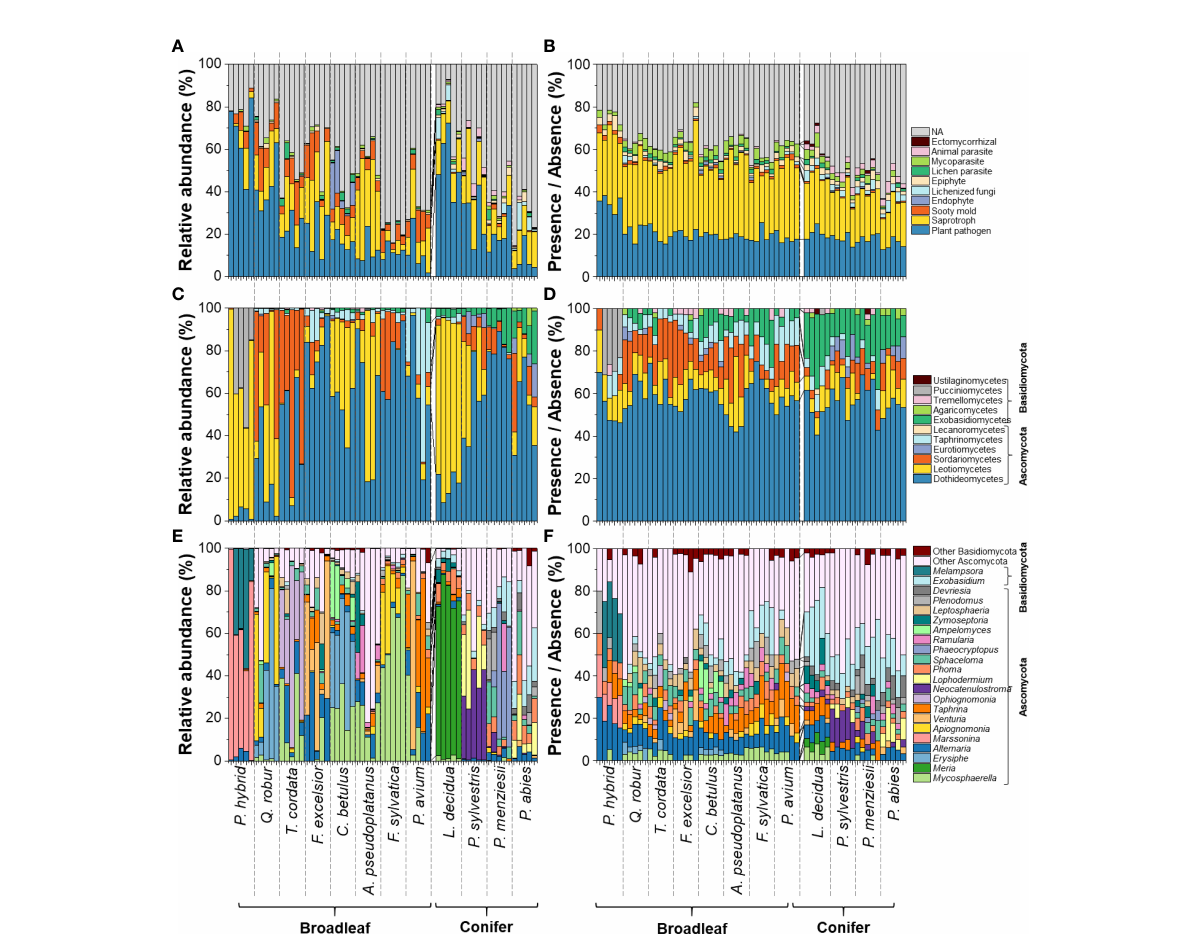
FIGURE 1 Compositions of fungal functional groups (A, B) and fungal plant pathogens (C – F) associated with senescing leaves of 12 temperate tree species at class (C, D) and genus levels (E,F) , considering only classes with ≥ 8 ASVs or relative abundances ≥ 2%. Remaining fungal classes and genera were pooled as “ others ” . Analysis based on relative abundance (left panel) and presence/absence data (right